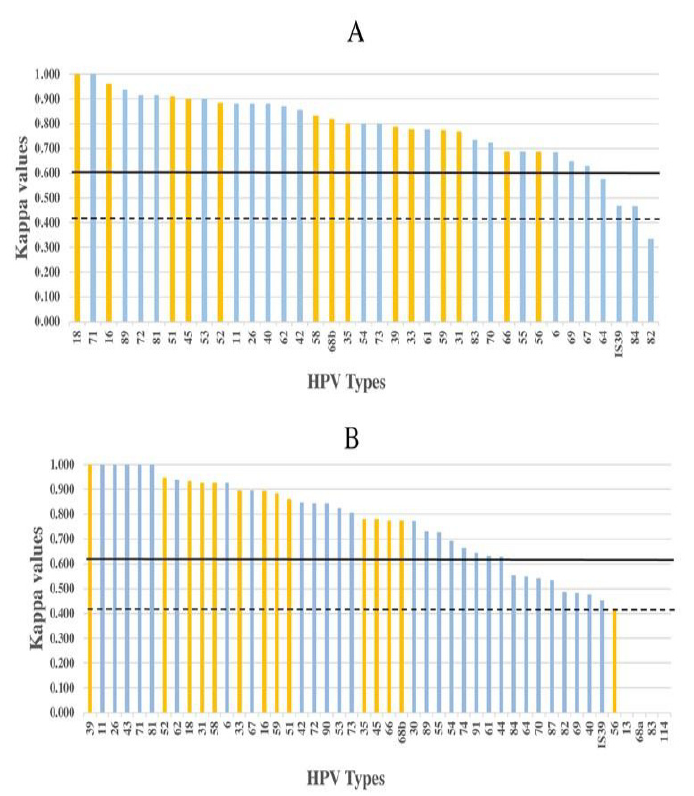
Figure 2. Individual HPV type-specific agreement as indicated by kappa values between PCR-15 and LA for 37 types ( A ), and between PCR-15 and TypeSeq for 47 types ( B ). HPV types are shown on the X-axis (yellow bars: HR types and others: LR types) and corresponding kappa values on the Y-axis. HPV types with kappa values crossing the black line represent >substantial agreement (k ≥ 0.61) between tests, whereas HPV types that fall between the black line and dashed black line represent moderate (k = 0.41–0.6) agreement between tests. Table 4. HPV type-specific concordance between PCR-15 and